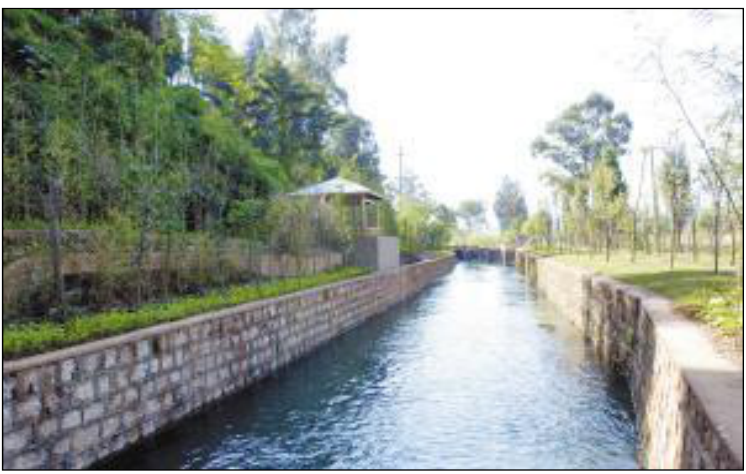
Figure 5. A current part of the Jing Zhi He